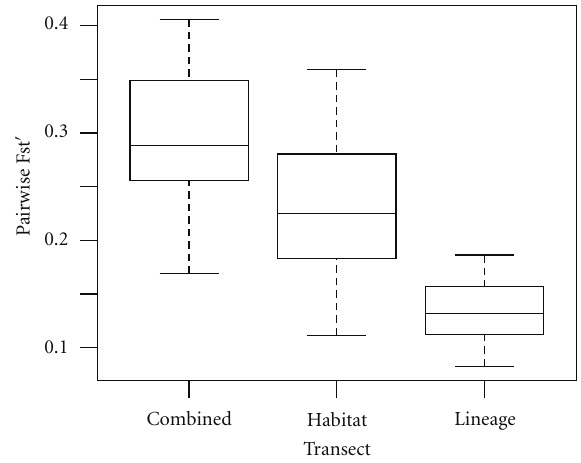
Figure 5: Box plot of the pairwise Fst’ values between populations across the lineage and/or habitat contact zone for the three tran-